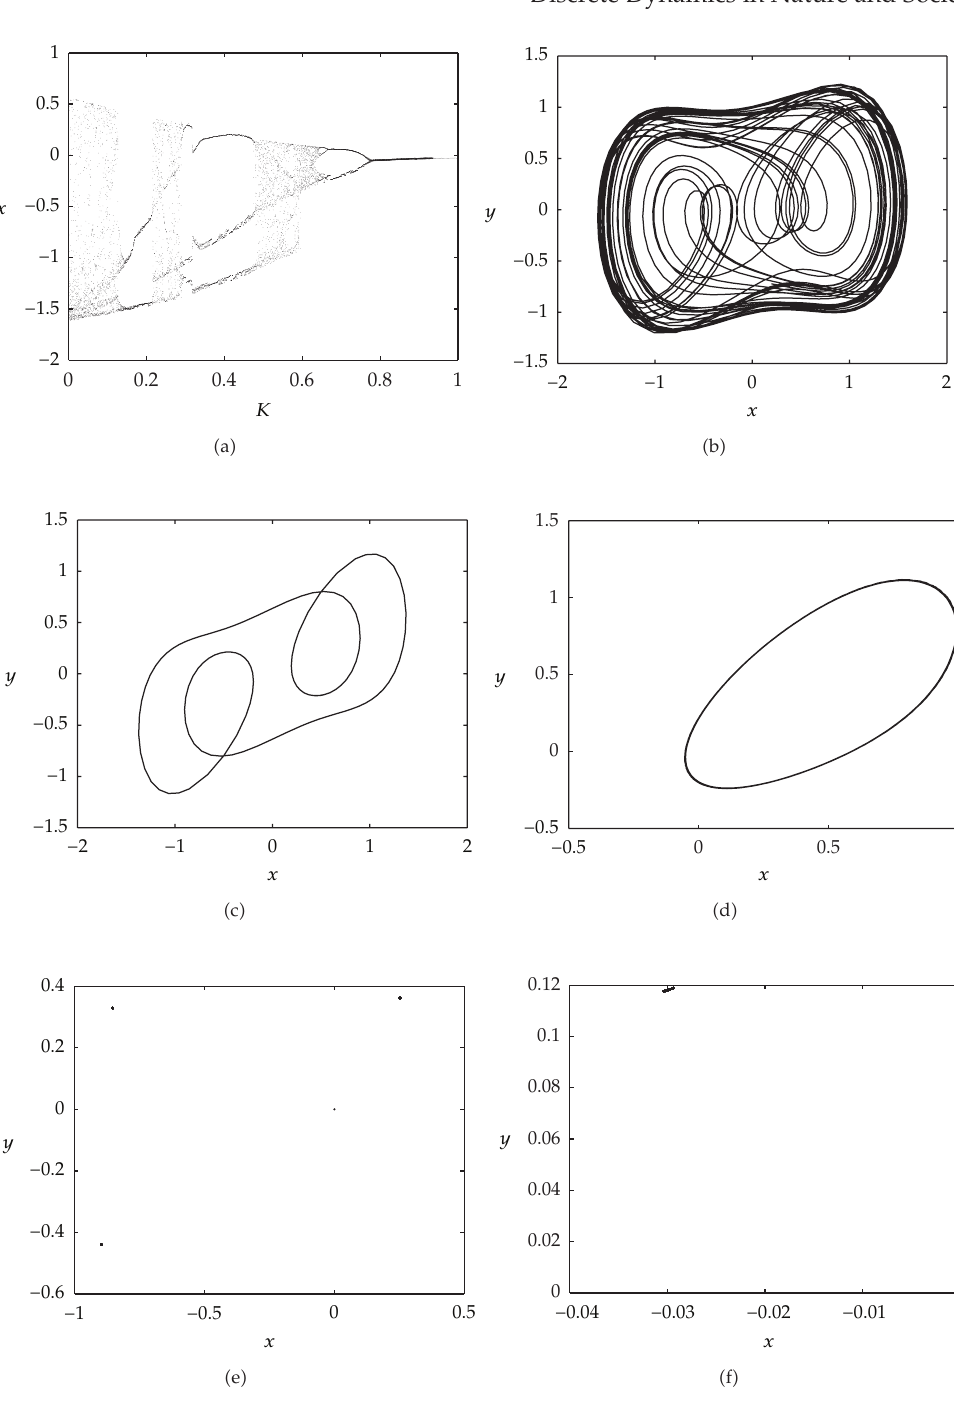
Figure 8: (cid:6) a (cid:7) Bifurcation diagram of the system (cid:6) 4.1 (cid:7) in K ∈ (cid:6) 0 , 1 (cid:7) . (cid:6) b, c, and d (cid:7) Phase portraits for three values of K in Figure 8 (cid:6) a (cid:7) . (cid:6) e (cid:7) Pioncar´e map of the system (cid:6) 4.1 (cid:7) for K (cid:8) 0 . 4. (cid:6) f (cid:7) Pioncar´e map of the system (cid:6) 4.1 (cid:7) for K (cid:8) 0 .